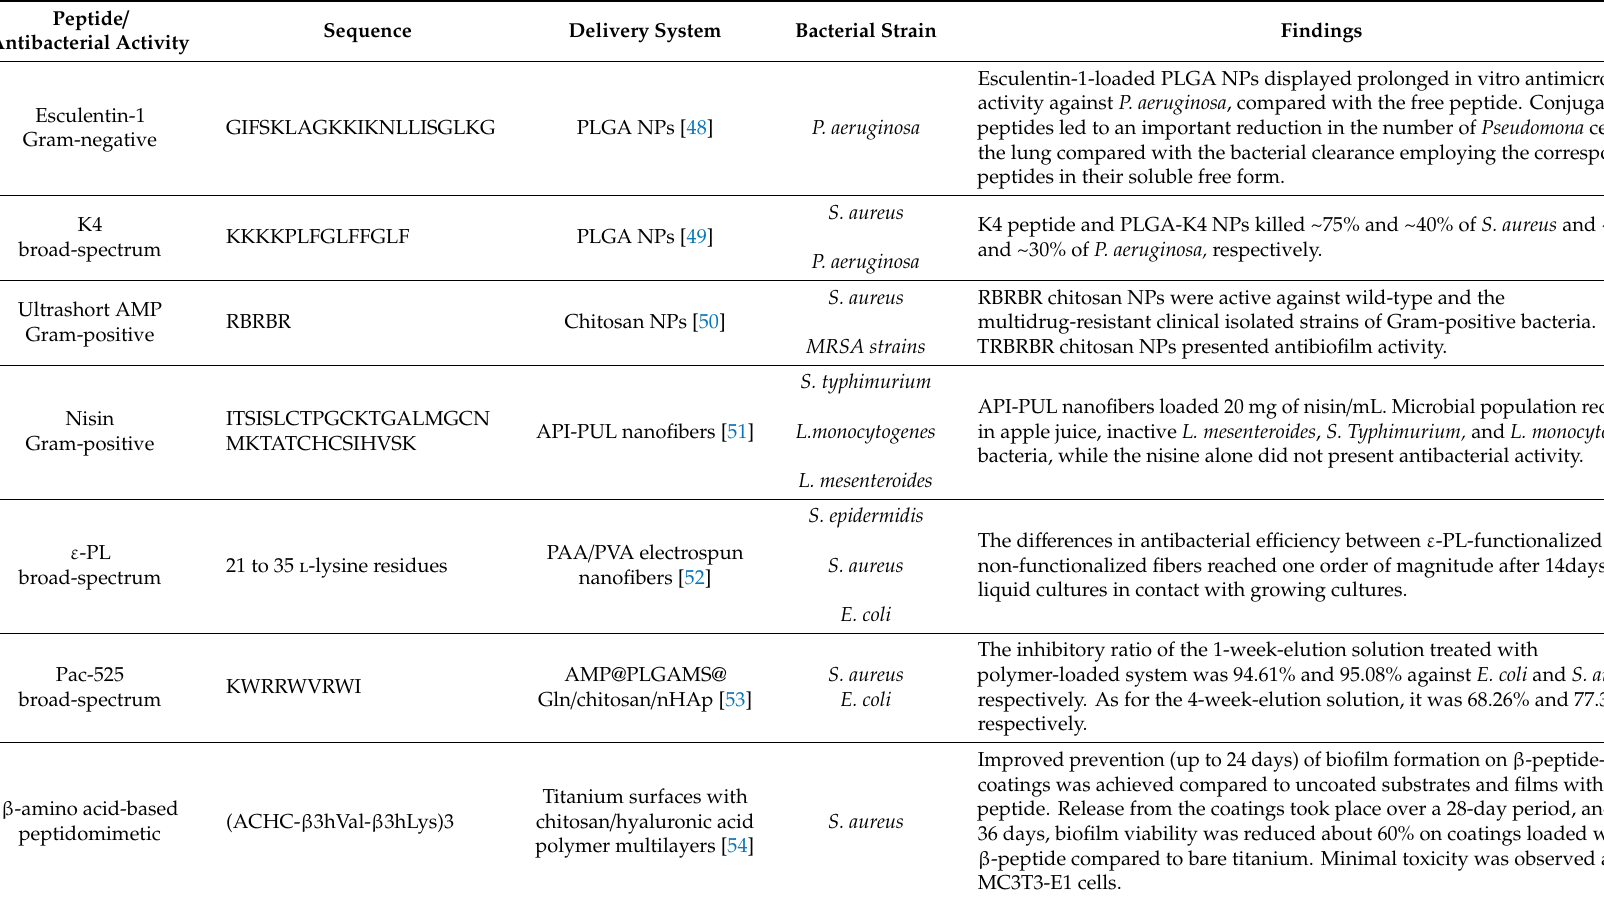
Table 3. Overview of the di ff erent polymers and hydrogels as a delivery system for